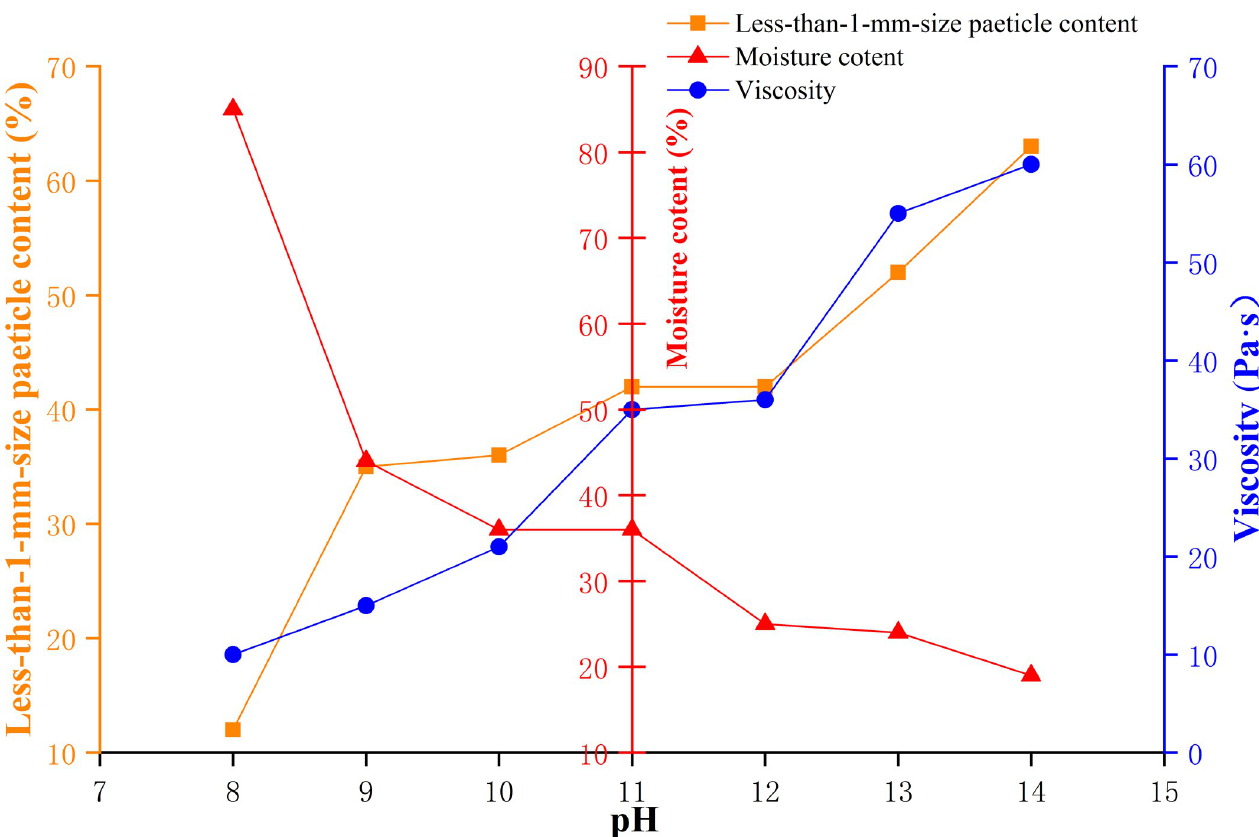
Fig 19. Effects of mud viscosity, water content and particle content smaller than 1 mm on the alkaline resistance of a mud film.